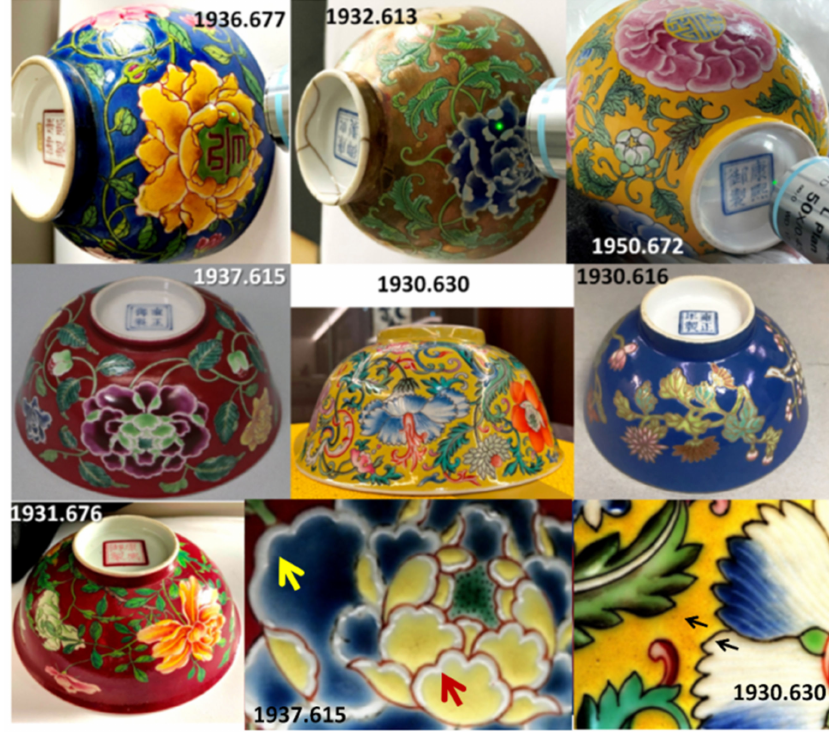
Figure 1. Views of the imperial bowls. The zooms show the extra thickness deposit (yellow and red arrows), the black lines separating the colored areas, and the heterogeneity of the colored areas (black arrows). See Table 1 for more information. For simplification, only the last three digits of the inventory number (after the point) are used in the text following the letter A.